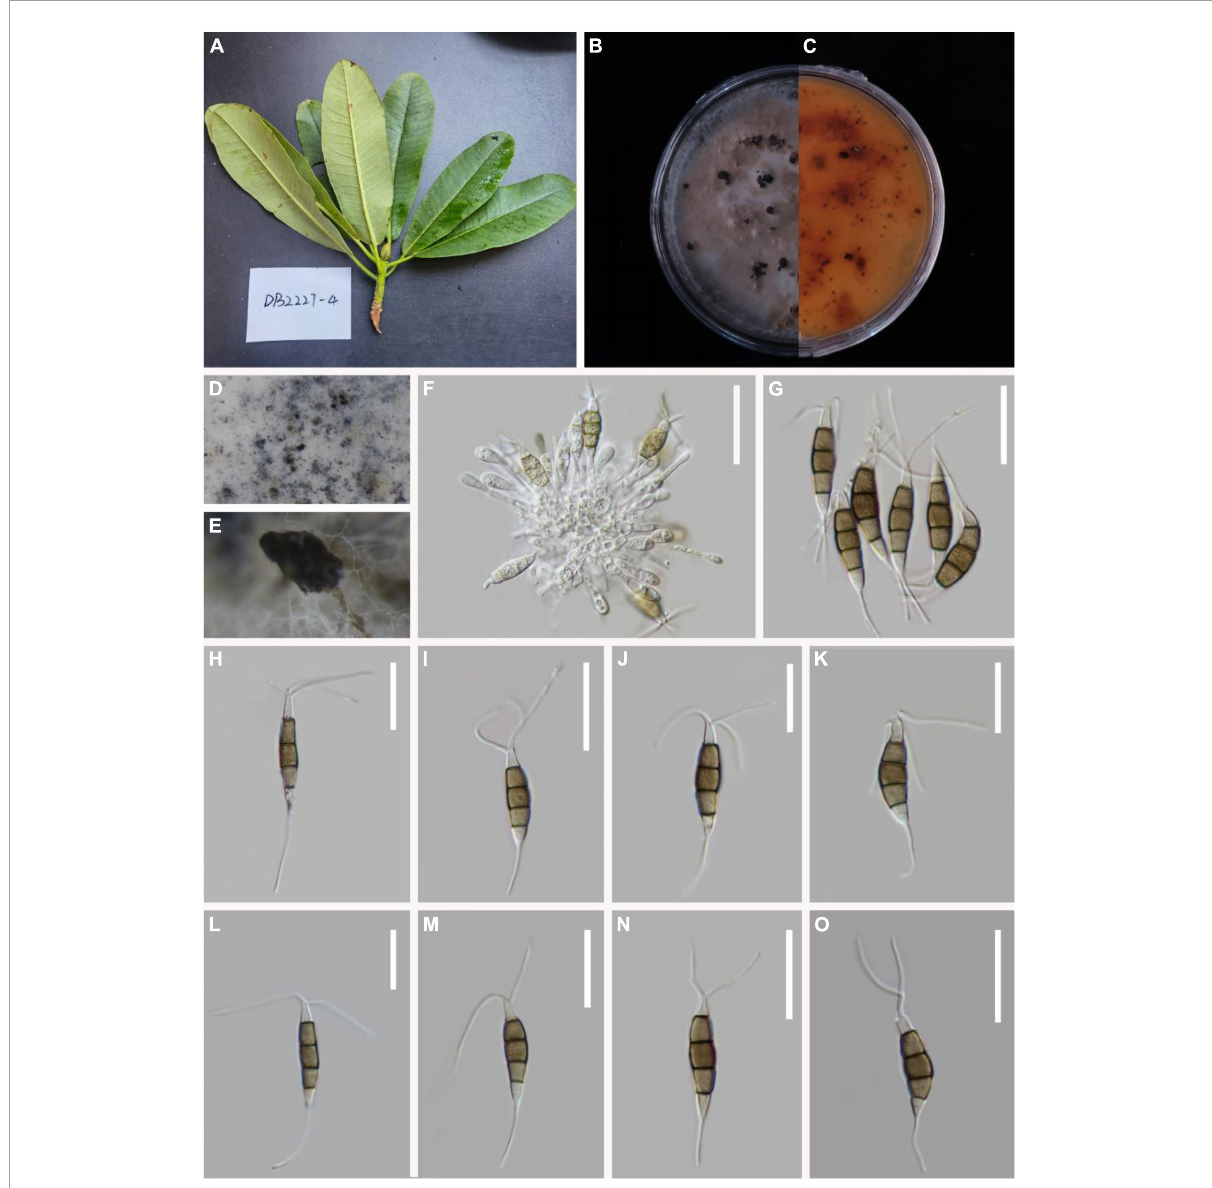
FIGURE4 Pestalotiopsis daliensis (KUN-HKAS 124576, holotype). (A) Leaves of Rhododendron decorum . (B,C) Culture on potato dextrose agar (PDA) (upper and lower view). (D,E) Conidiomata on PDA. (F) Conidiophores, conidiogenous cells, and conidia. (G–O) Conidia. Scale bars: (F) 25 µ m, (G) 15 µ m, and (H–O) 10 µ